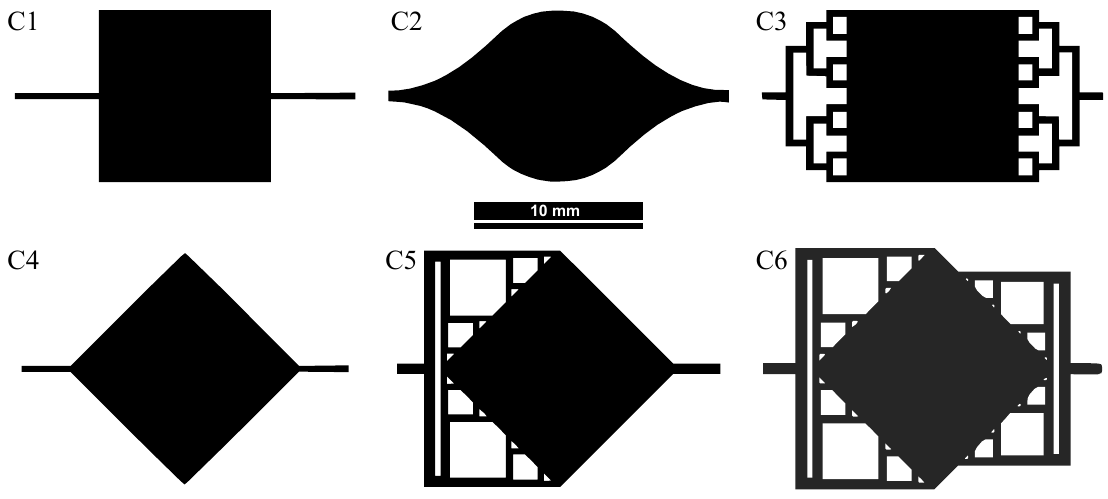
Figure 2. Simulated microfluidic interface topologies with 1 cm 2 chambers (scale bar is 10 mm).